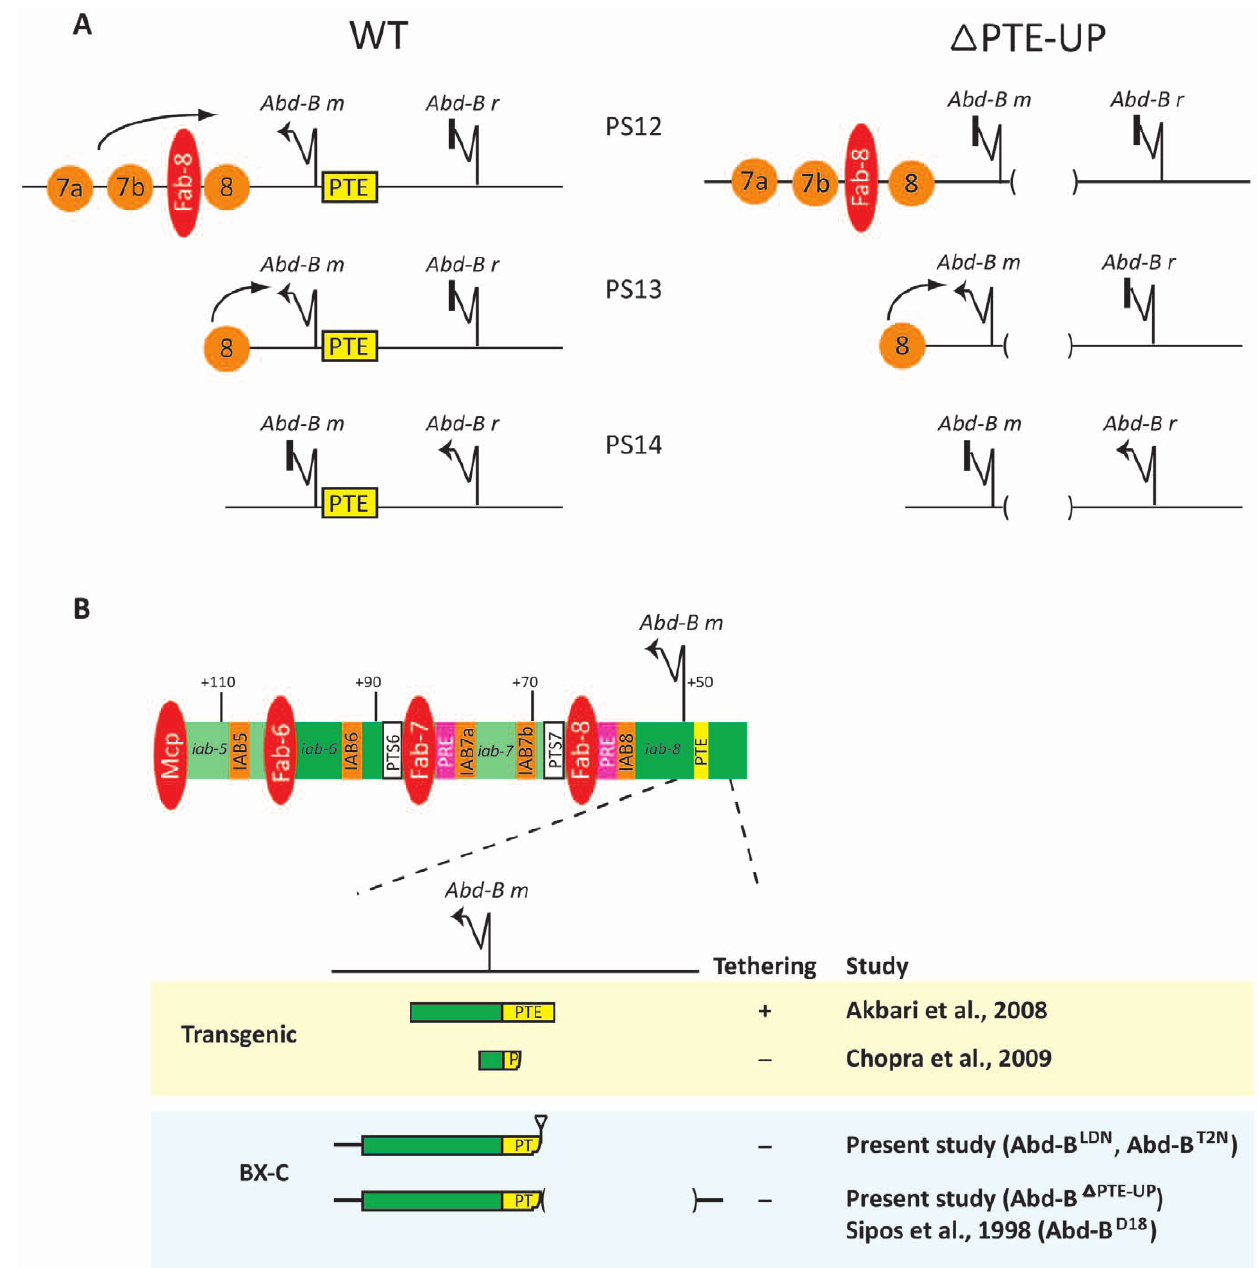
Figure 4. PTE sequence is required for specific promoter-enhancer tethering at the Abd-B gene. (A) Abd-B transcription is disrupted in PTE mutants. In wild-type (WT) germ-band elongation stage embryos expression from the Abd-B m promoter is observed in parasegments (PS) 10–13 and from the Abd-B r promoter in PS14 [29]. The loss of Abd-B expression in PS10–12 in Abd-B D PTE-UP ( D PTE-UP) embryos is consistent with a disruption of expression from the Abd-B m promoter. In PS12 of WT embryos, the tethering sequences upstream of the Abd-B m promoter enable the IAB7a and IAB7b enhancers (7a and 7b, orange circles) to act over the long-range of intervening sequence and bypass the Fab-8 chromatin insulator (red ellipse) and drive expression from the Abd-B m promoter. In PS12 of Abd-B D PTE-UP mutants the removal of the tethering sequences disrupts the ability of the IAB7 enhancers to activate the Abd-B m promoter across the intervening Fab-8 insulator. A similar disruption of promoter-enhancer tethering activity at Abd-B D PTE-UP is also seen in PS11 (IAB6 enhancer) and PS10 (IAB5 enhancer). In PS13 of both WT and Abd-B D PTE-UP embryos, IAB8 (8, orange circle) is able, due to its physical proximity and lack of intervening chromatin insulator, to drive expression from the Abd-B m promoter. In PS14 of both WT and Abd-B D PTE-UP embryos, Abd-B r is transcribed independently of IAB embryonic enhancer activity and represses transcription from the Abd-B m promoter [28]. (B) Functional dissection of critical Abd-B tethering sequences. Schematic diagram of the regulatory region of the Abdominal-B gene shows enhancers (orange boxes) in the infraabdominal regions iab-5 to iab-8 (green) that are responsible for activating expression of the Abd-B gene in abdominal PS 10–13 during embryogenesis. Color scheme for other types of cis -regulatory modules is same as in Figure 1. Transgenic studies (highlighted in yellow box) show that a 1.4 kb of sequence from + 1228 to 2 294, (including the 255 bp PTE sequence located 40 bp 5 9 of the Abd-B m transcription start site), is sufficient for promoter-enhancer tethering [16]. Additional transgenic studies have shown that an approximately 200 bp sequence spanning the Abd-B m transcription start site ( + 100 to 2 100) is not sufficient for tethering activity [36]. P element insertion at the endogenous BX-C (as in the Abd-B LDN or Abd-B T2N mutations) demonstrates that the 242 bp sequence 5 9 of the Abd-B m transcription